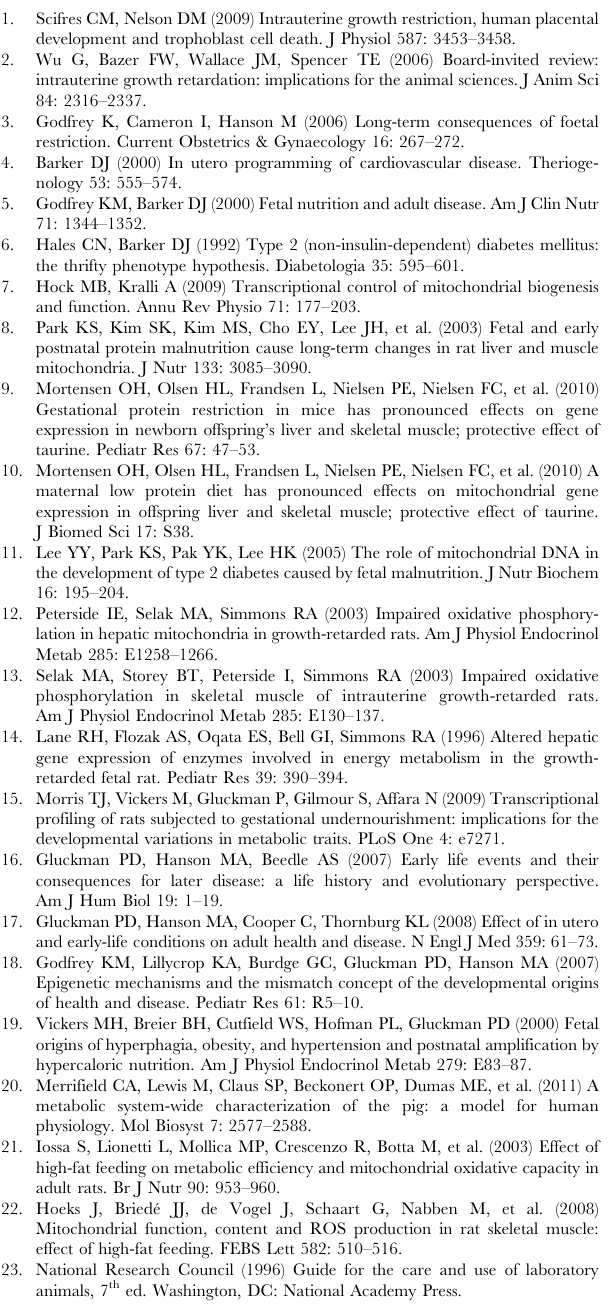
Figure 9. Influence of IUGR and diet on mRNA levels of Glucokinase (A), citrate synthase (CS, B), adenosine triphosphate synthase (ATPS, C), cytochrome c oxidase I (CcOX I, D), cytochrome c oxidase IV (CcOX IV, E), cytochrome c oxidase V (CcOX V, F), Cytochrome c (Cyt c, G) and NADH dehydrogenase subunit 4 (ND4, H) in skeletal muscle of pigs. C: Control diet; HF: High-fat diet; NBW: Normal birth weight; IUGR: Intrauterine growth retardation. Data are expressed as group means 6 SEM. * P values next to each label represent the significance in the effect for each source of variation (IUGR or diet) as calculated by ANOVA. 1 P , 0.05 in post hoc test comparing IUGR and NBW offspring receiving the same diet (n=8 by